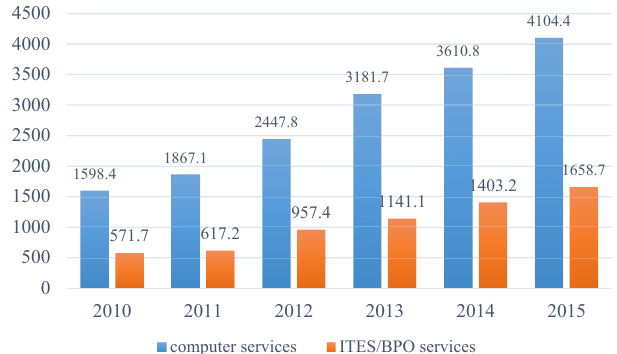
Figure 3. Export of computer and ITES/BPO services (in bn